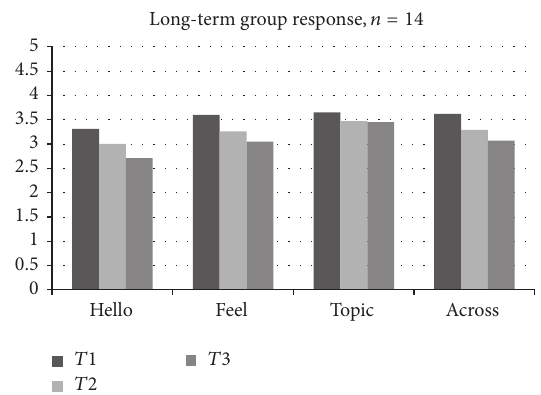
Figure 2: Long-term group prompt scores across time points.